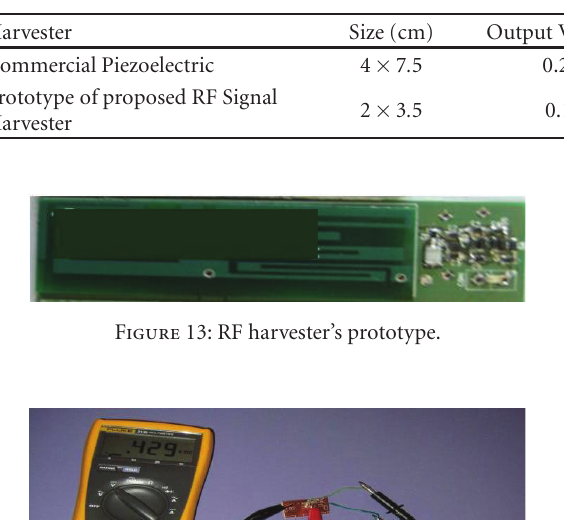
Table 3: Comparison between commercialized piezoelectric harvester and the proposed RF signal harvester.